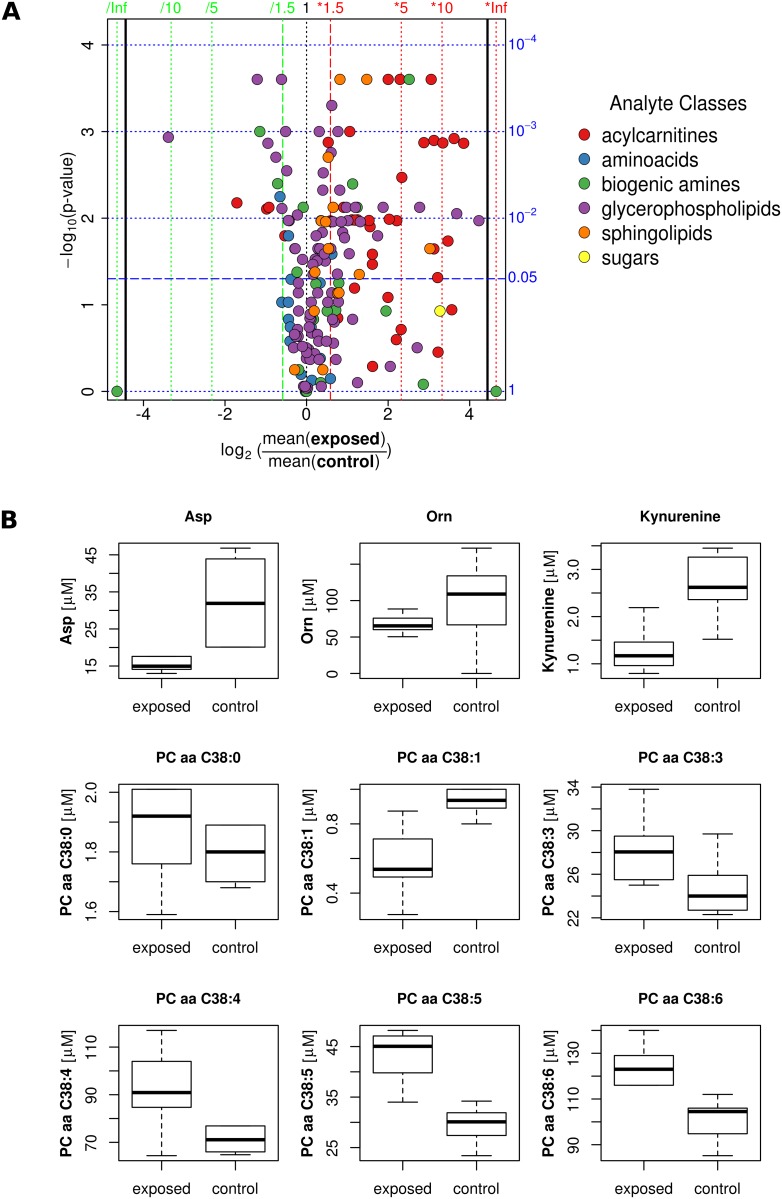
Serum metabolome profile indicates significant changes in lipids and carnitines.
(A) Volcano plot (fold-change vs significance) of the comparison between metabolites of the exposed group and the control group of female 129S6 mice. The color code for different analyte classes is shown. (B) Box-and-whisker plot of selected metabolites. Medians, interquartile ranges (boxes) as well as minimal and maximal values (whiskers) are indicated. Significant differences between metabolites are marked with: *p<0.05, ** p<0.01, *** p<0.001, **** p<0.0001.